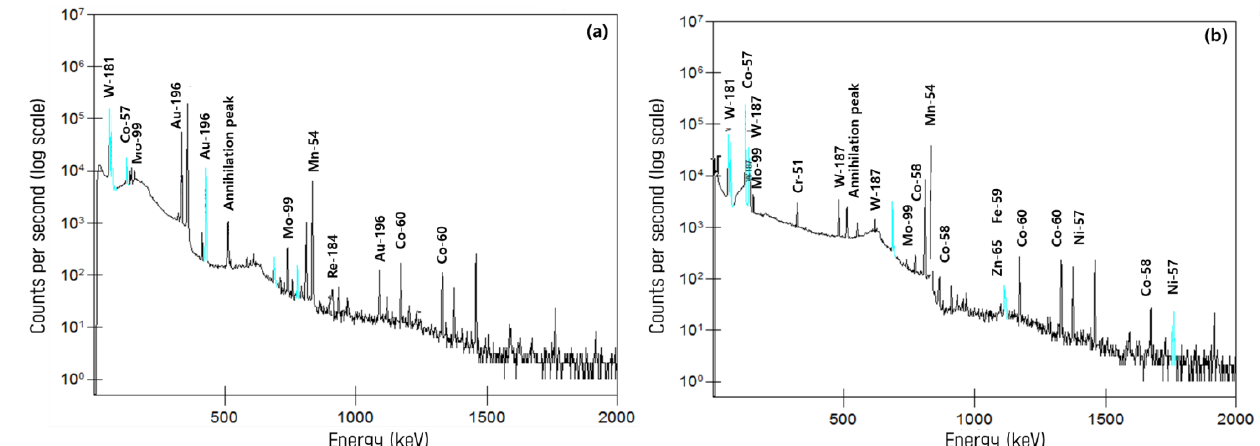
Figure 6. Two examples of the linac component spectrometry with HPGe detector: ( a ) Target, ( b ) 15 MV Primary Collimator. (Blue line: double peak)